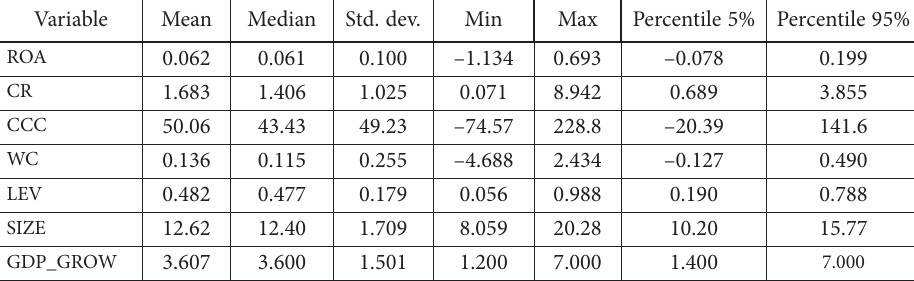
Table 3. Descriptive statistics of the research sample (source: own elaboration)